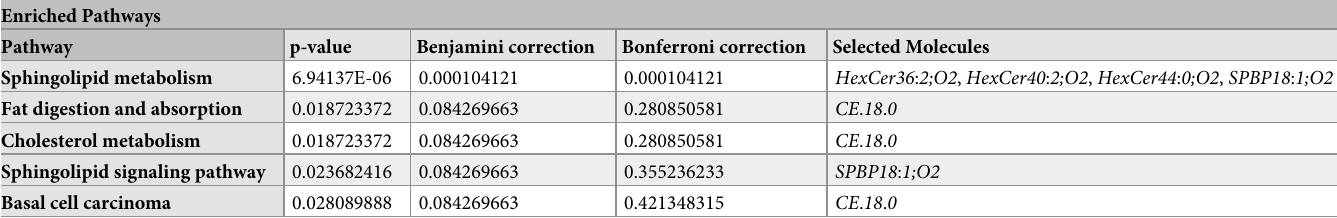
Table 18. Enrichment analysis of lipids associated with COVID-19 severity (COVID-19 patients). Enriched Pathways